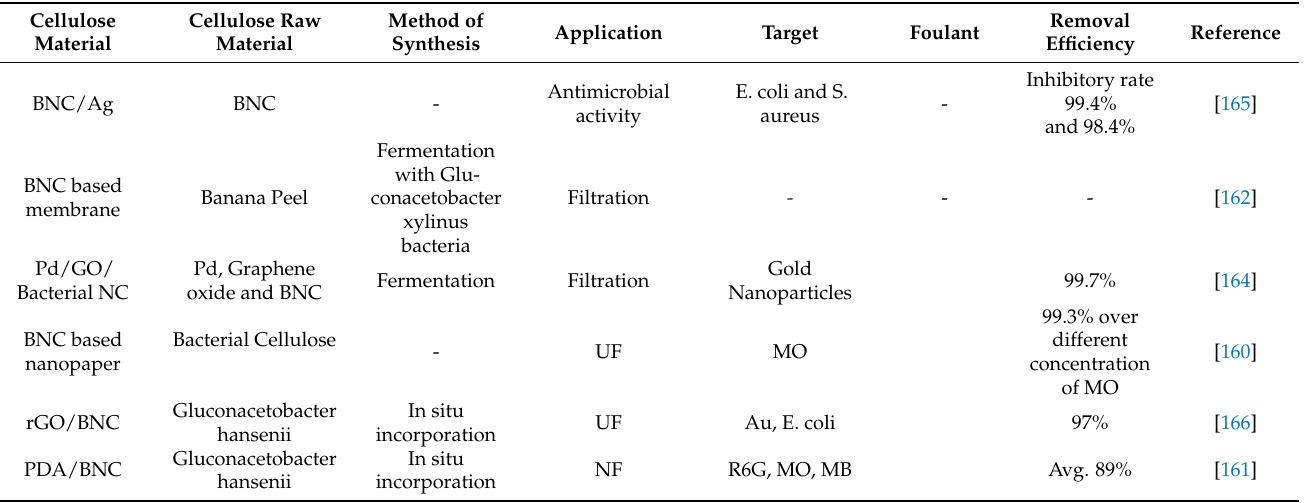
Table 4. The overview of the studies carried out using BNC-based membranes for the desalination and water treatment